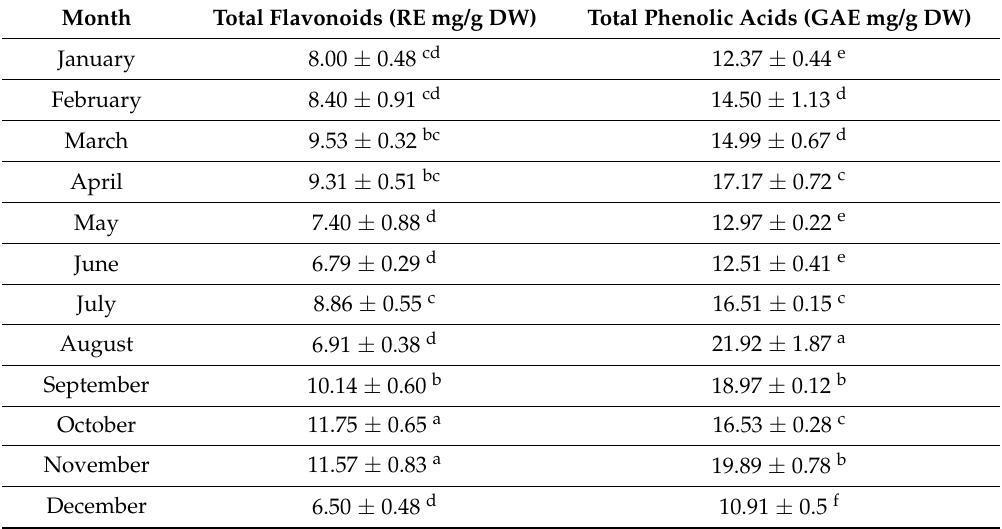
Table 1. Total flavonoids and total phenols contents of samples from twelve months. Total Flavonoids (RE mg/g